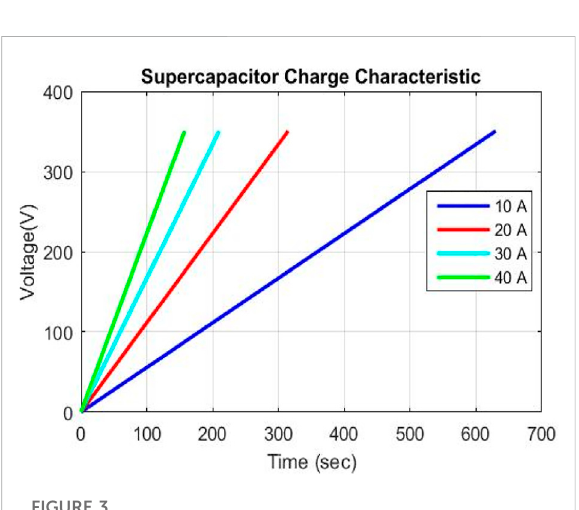
FIGURE 3 Supercapacitor characteristic